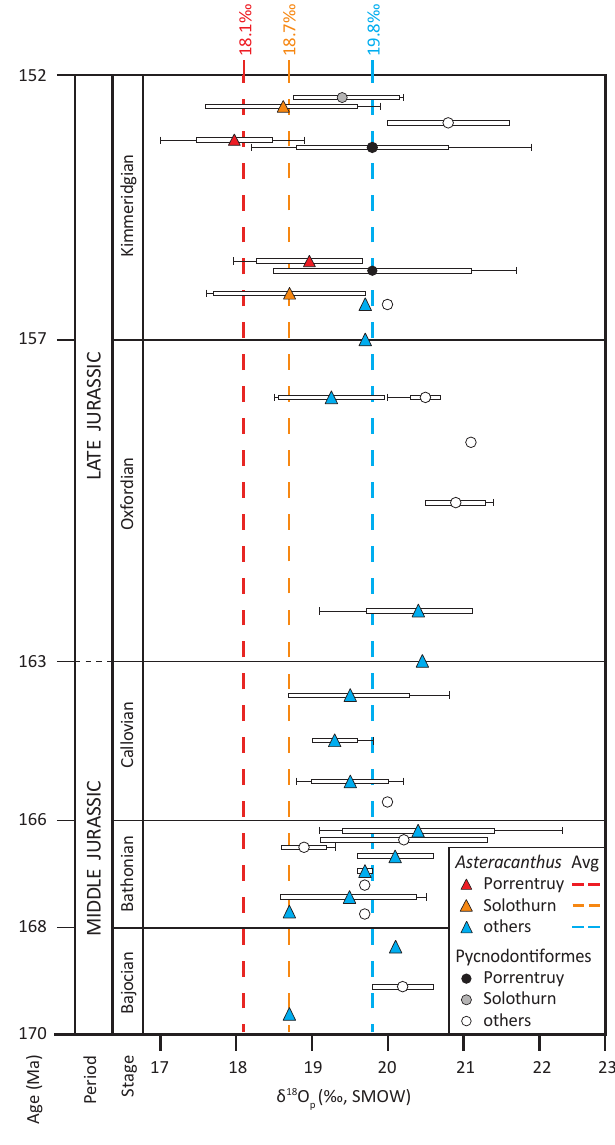
Figure 5. Comparison of δ 18 O p values (average, standard devia- tion, end members) of Pycnodontiformes and Asteracanthus enam- eloid samples from Porrentruy, Solothurn and other European lo- calities through time. The stratigraphical position is approximate and corresponds to Early, Middle, Late divisions of each stage. The approximate geographical positions of previously studied localities (Dromart et al., 2003; Lécuyer et al., 2003; Billon-Bruyat et al., 2005) are shown in Fig. 1. Detailed localities and stratigraphic po- sitions are available in the